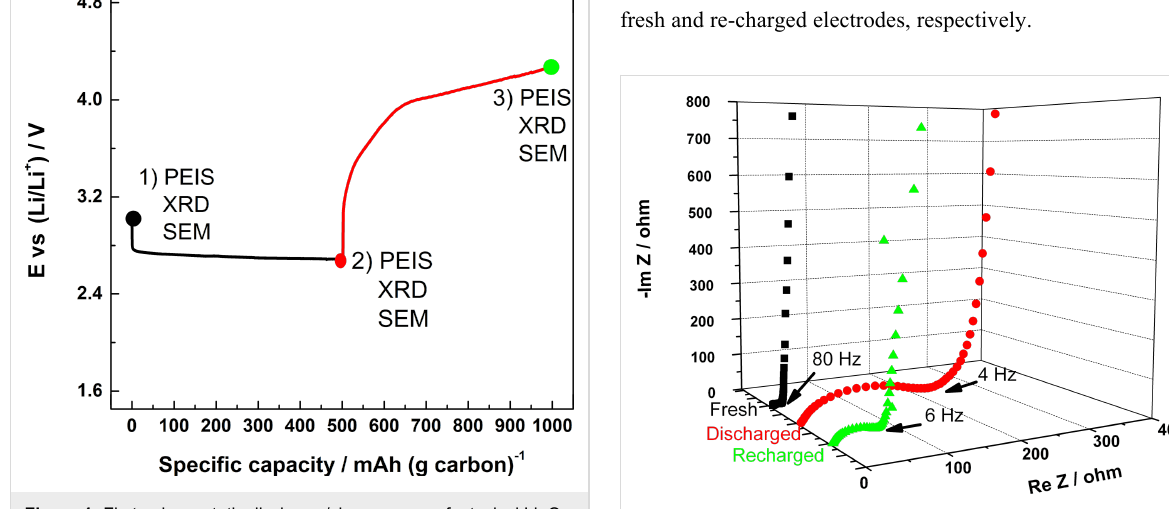
By means of X-ray diffraction we confirmed the reversible